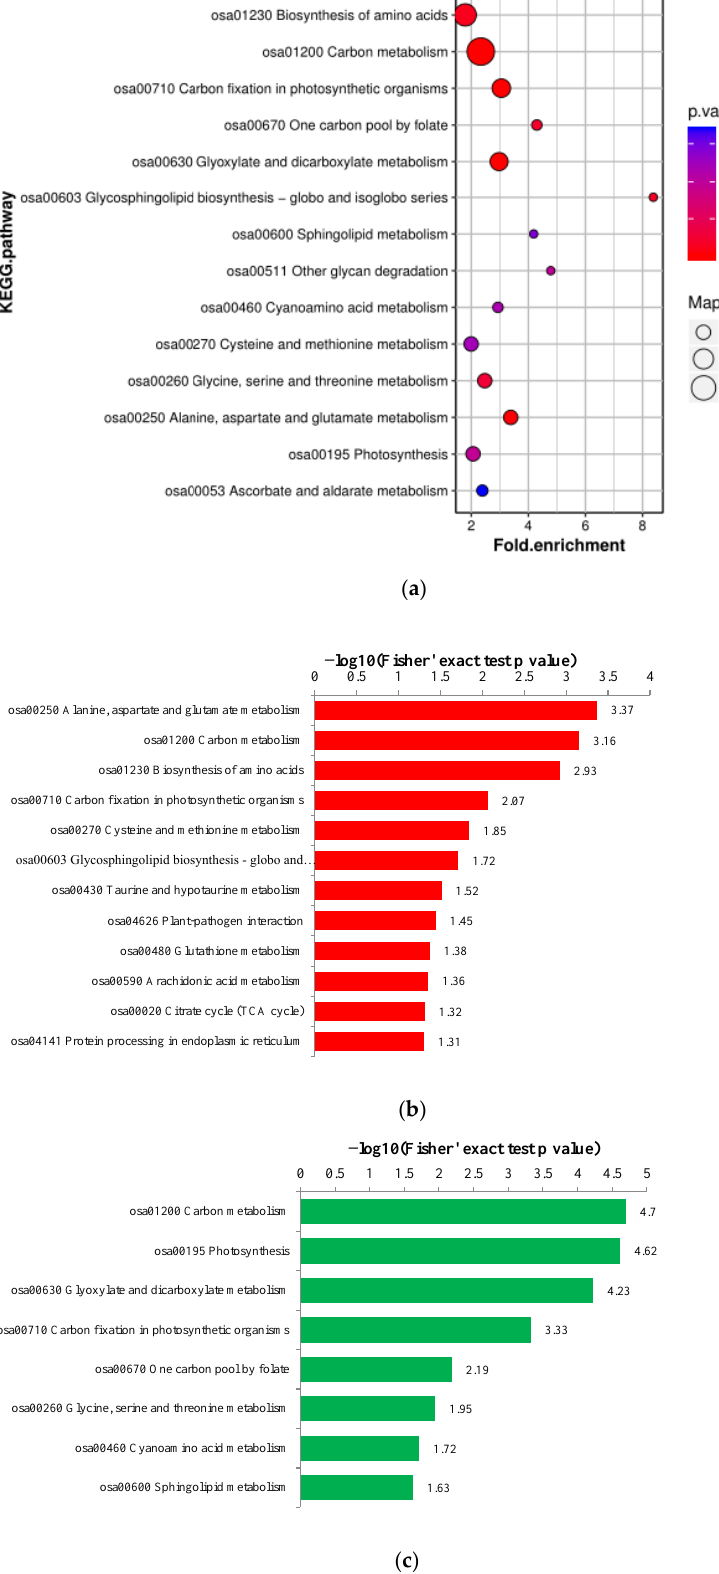
Figure 6. KEGG pathway enrichment of photosynthetic enzymes; all proteins ( a ), up-regulated proteins ( b ), and down-regulated proteins ( c ). Note:Values on the horizontal axis are negative log-transformations of significant p -values ( p < 0.05).